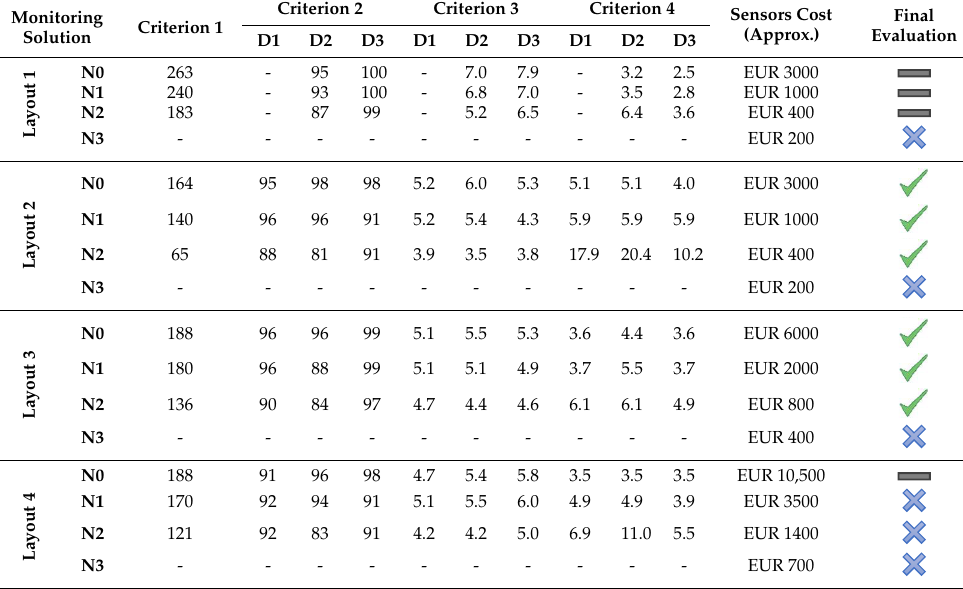
relative disadvantage; advantage depends on the circumstances.